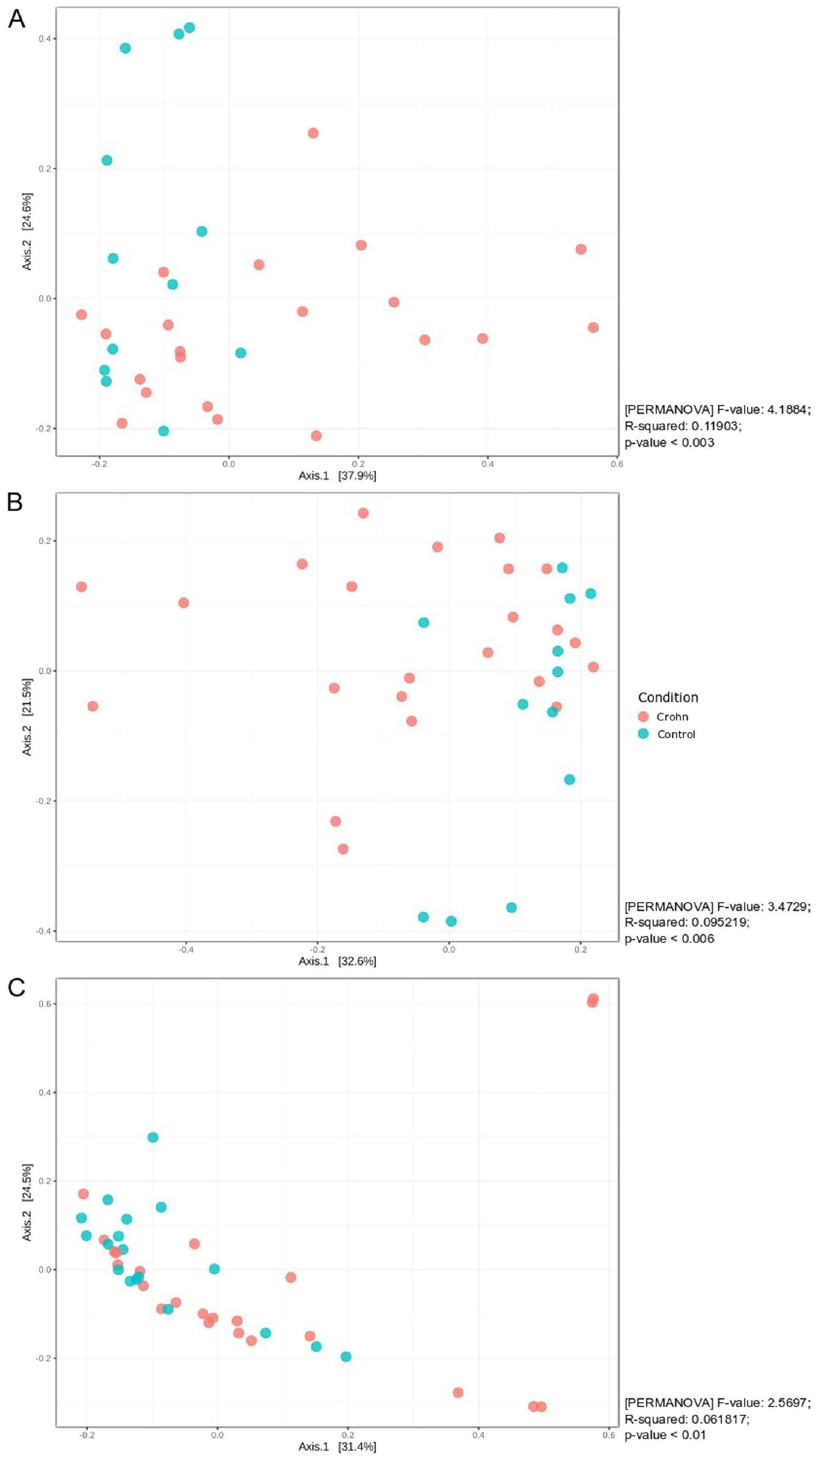
Figure 2. Principal coordinates analysis of HP-negative samples using the Bray–Curtis index as a distance measure. The significance of the clustering patterns was tested using PERMANOVA. ( A ) Corpus; ( B ) antrum; ( C ) gastric